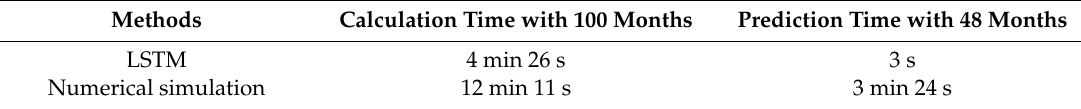
Table 6. Comparison for computational time between LSTM and numerical history matching.